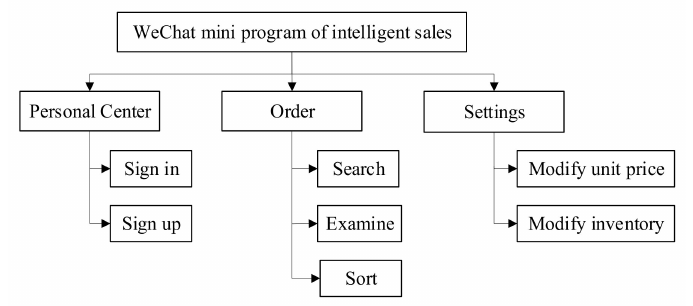
Figure 15. The functional block diagram of the mini